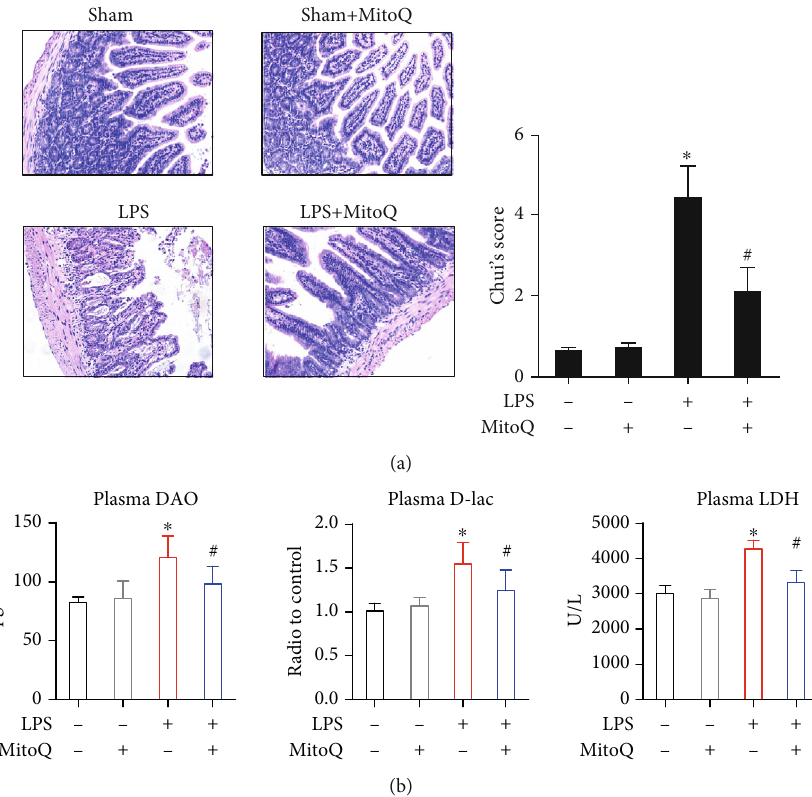
Figure 1: MitoQ ameliorates LPS-induced intestinal injury. (a) Representative images of intestinal histology (H&E staining); (b) Levels of DAO, D-lac, LDH in plasma. Data are expressed as the mean ± SD . ∗ P < 0 : 05 vs. control group; # P < 0 : 05 vs. LPS